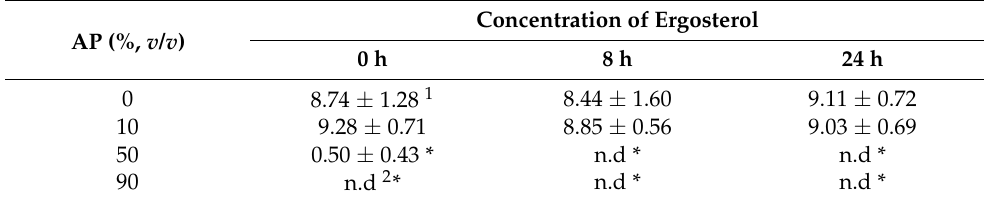
Table 3. The concentration of ergosterol ( µ g/mL) when co-inoculated (10 µ g/mL) with different amounts of antifungal preparation (AP) at different sampling